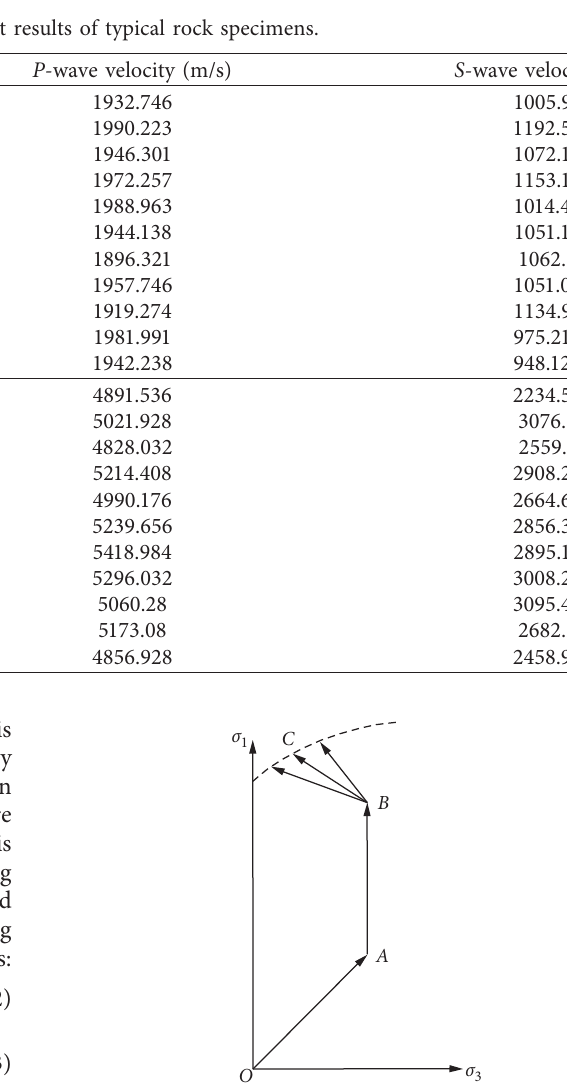
Figure 2: Stress path of the unloading confining